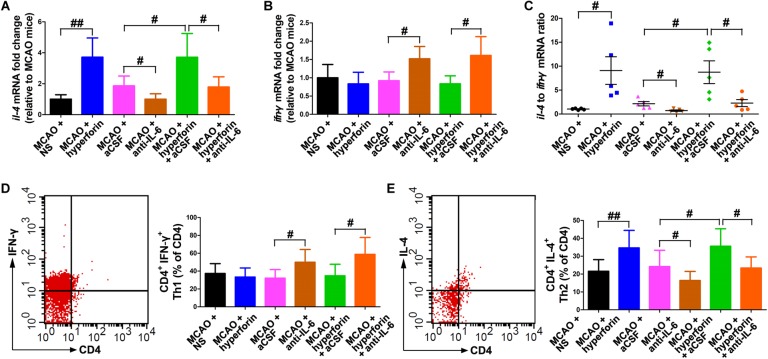
Hyperforin promoted Th2 cell differentiation in the ischemic hemisphere via IL-6 during stroke recovery. Real-time PCR analysis of the mRNA levels of il-4
(A) and ifn-γ
(B), and their ratio (C) in the ischemic hemisphere for each group at 28 dpi. Data represent mean ± SD, n = 5; #P < 0.05 and ##P < 0.01. T lymphocyte subsets of ischemic hemisphere in each group as measured by flow cytometry. The mononuclear cells were harvested from ischemic hemisphere and strained with various combinations of antibodies [Th1: CD4+ IFN-γ+
(D); Th2: CD4+ IL-4+
(E)] at 28 dpi. Data represent mean ± SD, n = 5; #P < 0.05; ##P < 0.01. aCSF, artificial cerebrospinal fluid; Th1, T helper (Th) type 1 cells; Th2, T helper (Th) type 2 cells.